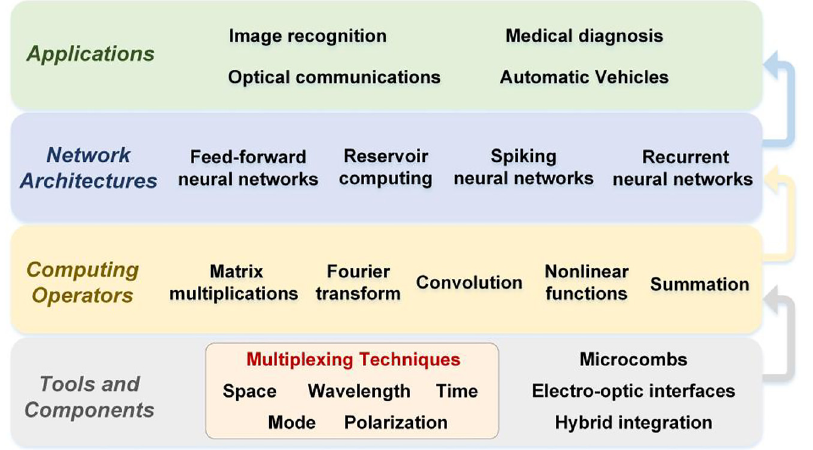
Figure 1: The different facets of optical neural